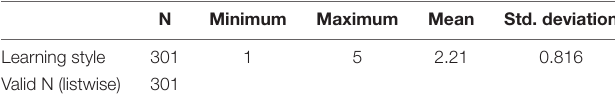
TABLE 11 | Descriptive statistics of the questions related to the learners’ learning styles in technology-integrated classrooms.